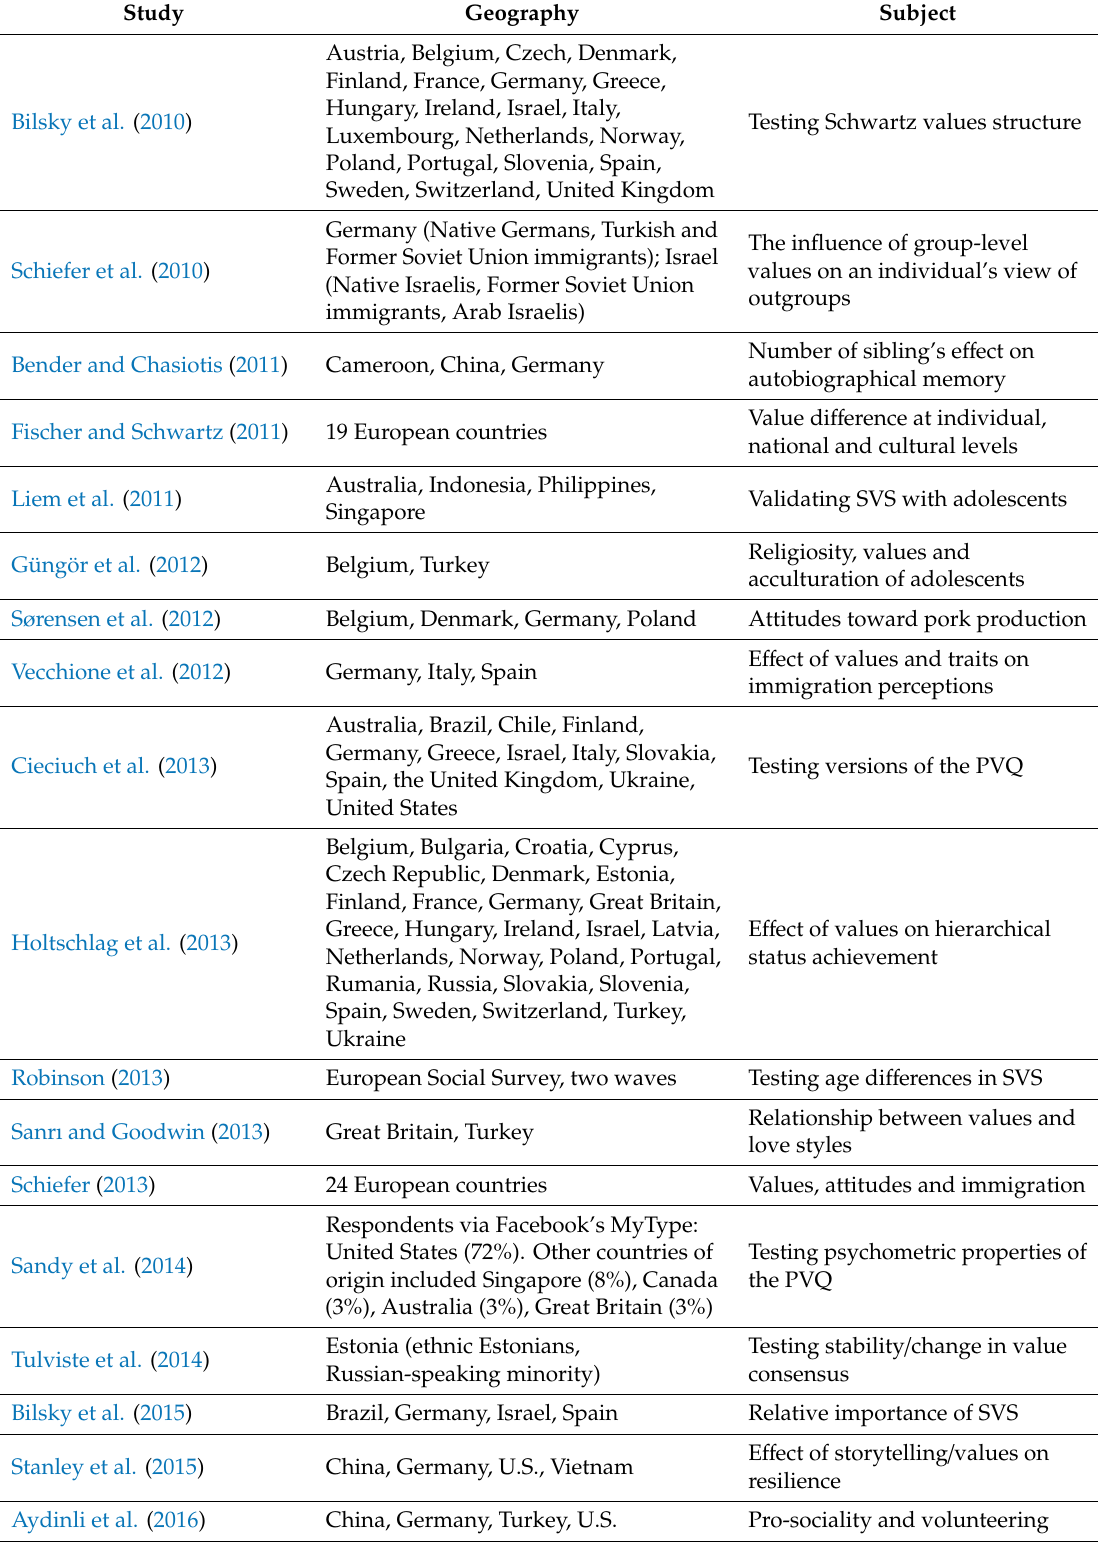
Table 3. Uses of the Portrait Values Questionnaire (PVQ), 2010–2020 in comparative cultural